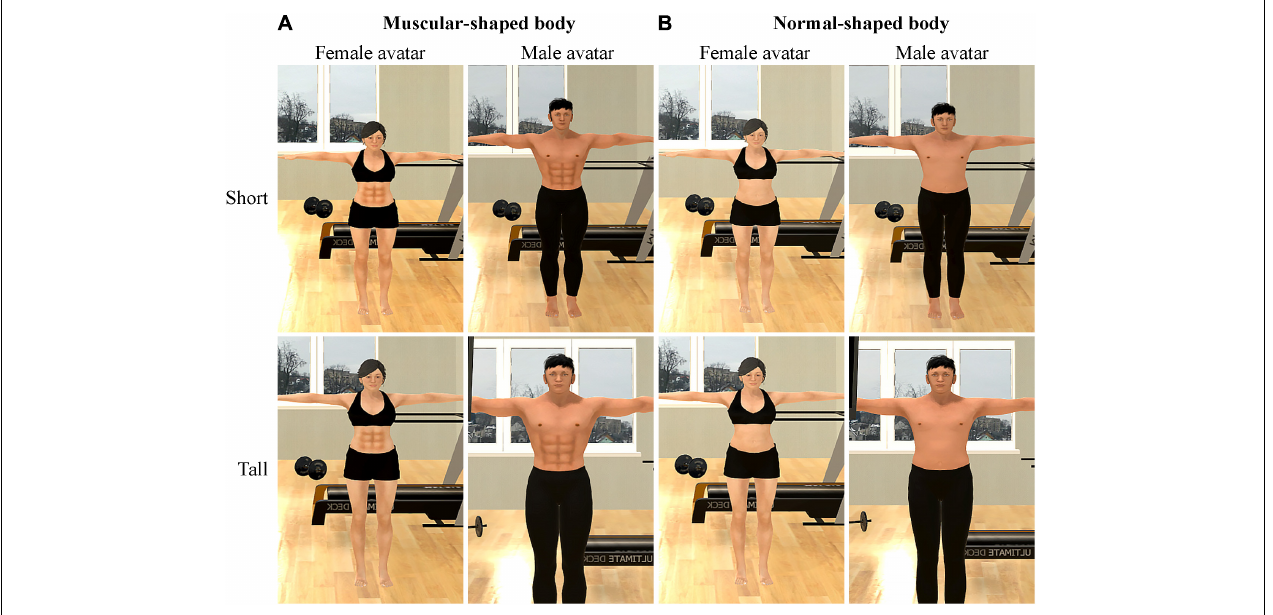
FIGURE 1 | Avatars. (A) The female and male avatars with muscular-shaped bodies. (B) The female and male avatars with normal-shaped bodies. (The upper row shows the short avatars for the participants who were shorter, and the lower row shows the tall avatars for the participants who were